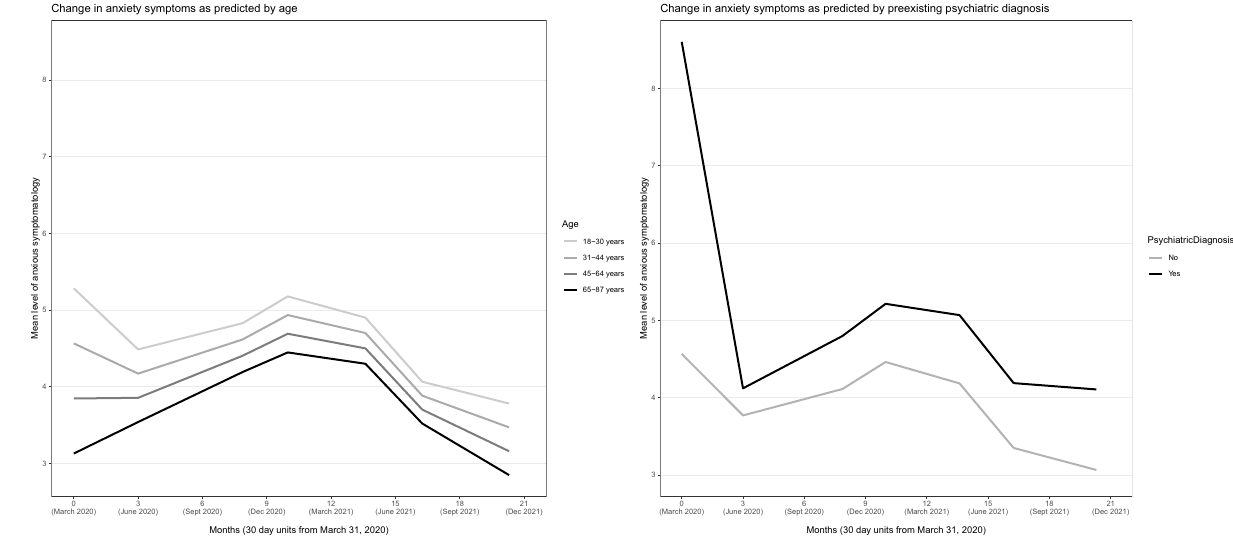
Figure 3. Anxiety across the 20-month observation period as predicted by age and preexisting psychiatric diagnosis. Controlled for the influence of all other variables in the model.